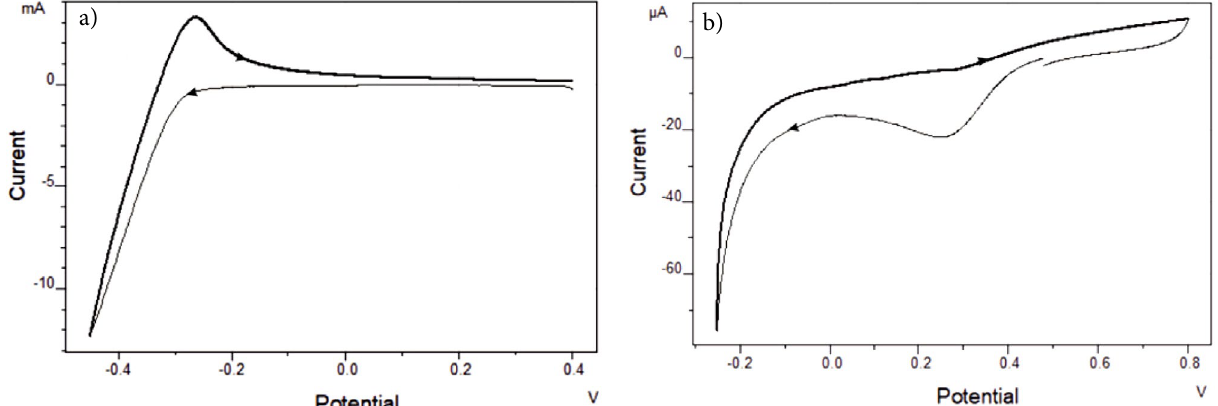
Fig . 1 . Cyclic voltamperometric curves of the electroreduction process of the molybdate ions in the presence of tartaric acid on the Pt electrode. The electrolyte consists of: 0.1 M Na 2 MoO 4 2H 2 O + 0.007 M C 4 H 6 O 6 . Т = 293 К, Е V = 0.02 V/s. а –the general process, b- the initial stage.